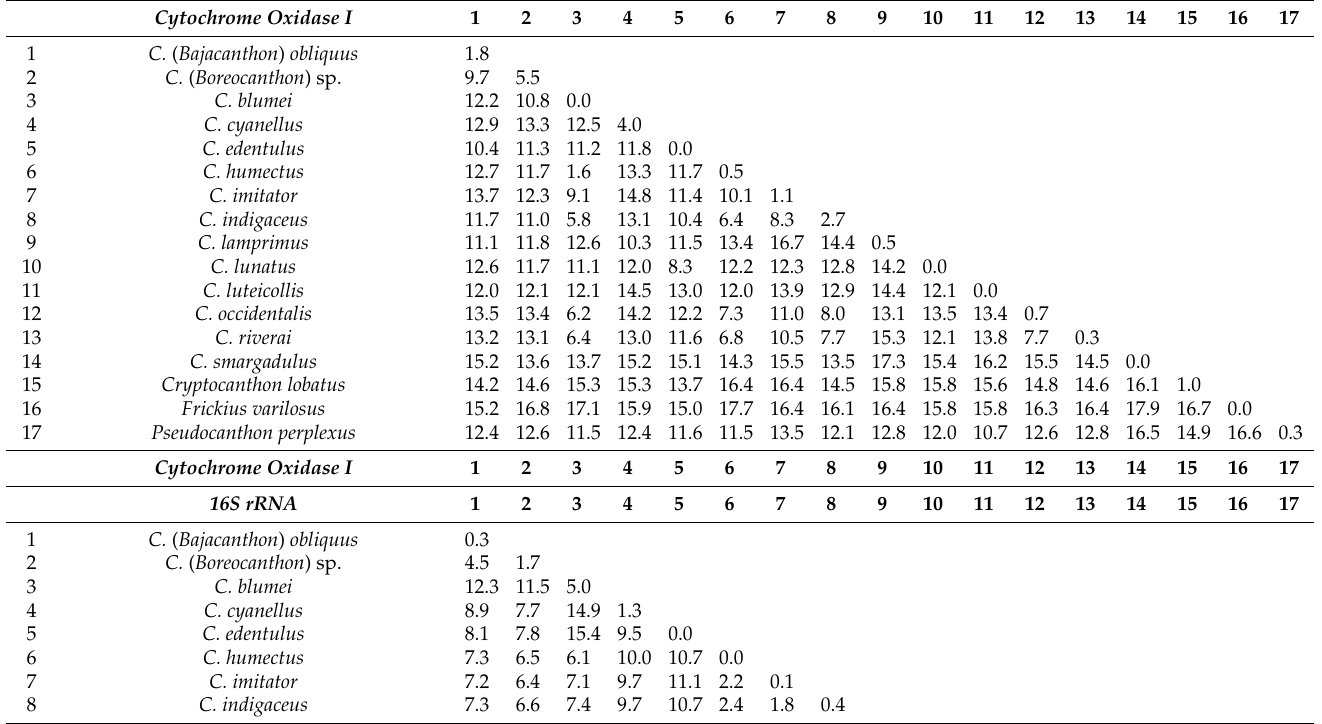
Table 2. Pairwise corrected genetic distances based on the Kimura two parameter model of nucleotide substitution. Diagonal line is the intra-taxon corrected